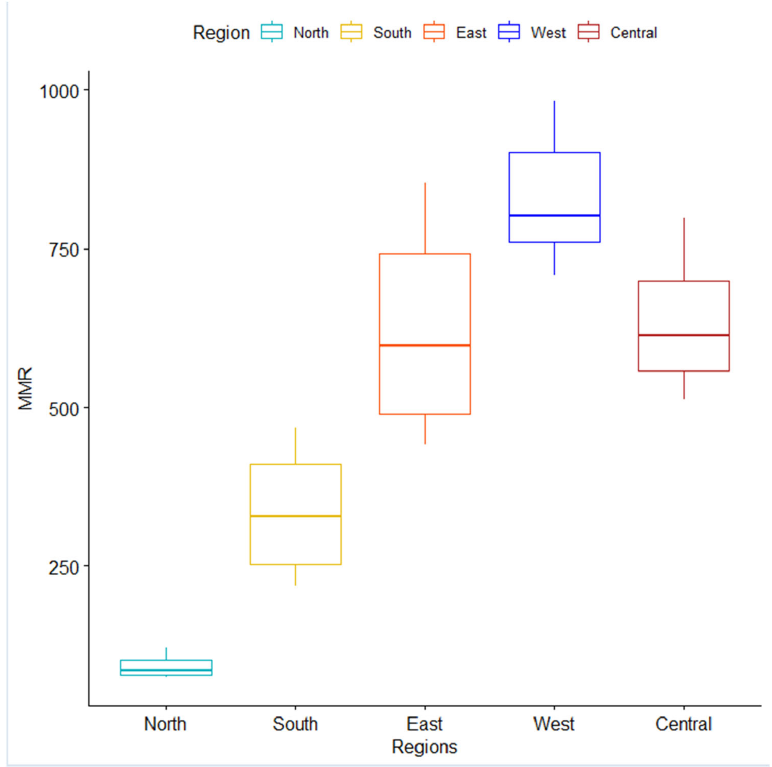
Figure 3. Maternal Mortality Rates in Africa (2000–2017) by